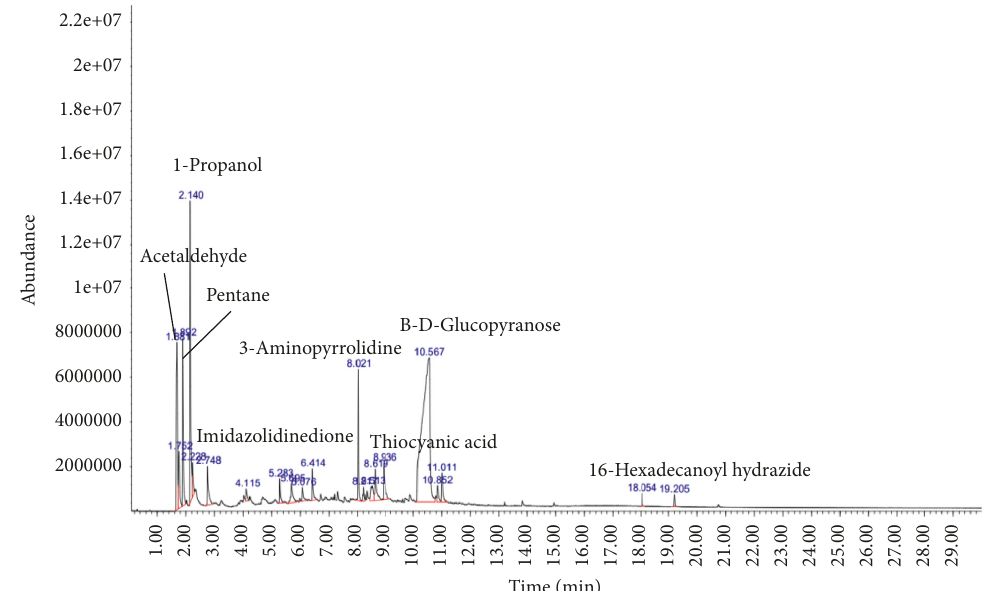
Figure 7: Results of pyrolysis GC-MS (600 ° C); it shows phytochemical compounds (The raw data is available in the supplementary file (available (here))). Table 1: Compounds identified in pyrograms from